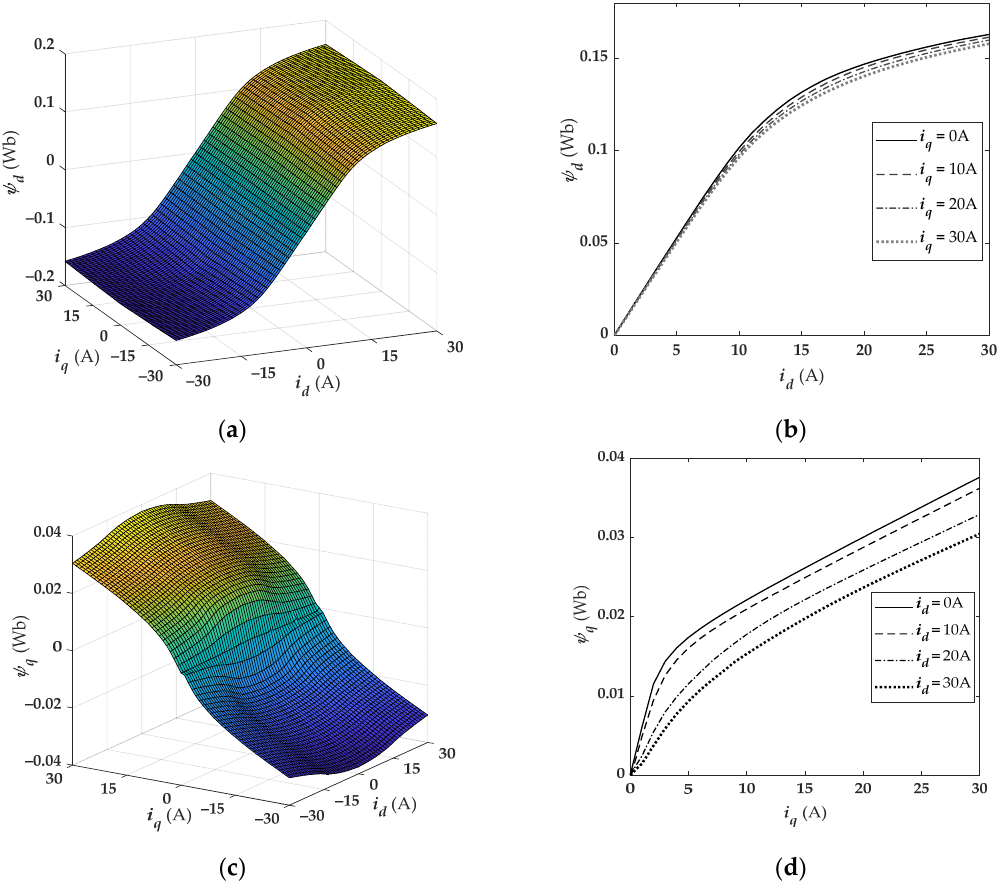
(cid:0) (cid:1) i d , i q , ( b ) d -axis ψ d ( i d ) with different